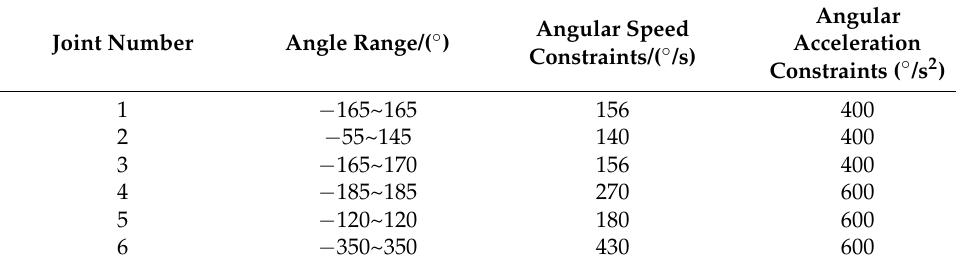
Table 1. Joint motion range and